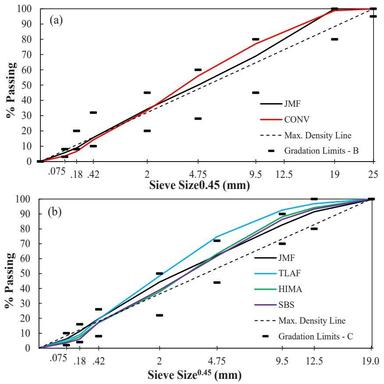
Gradation of mixtures: (a) base layer mixture, (b) surface layer mixtures.